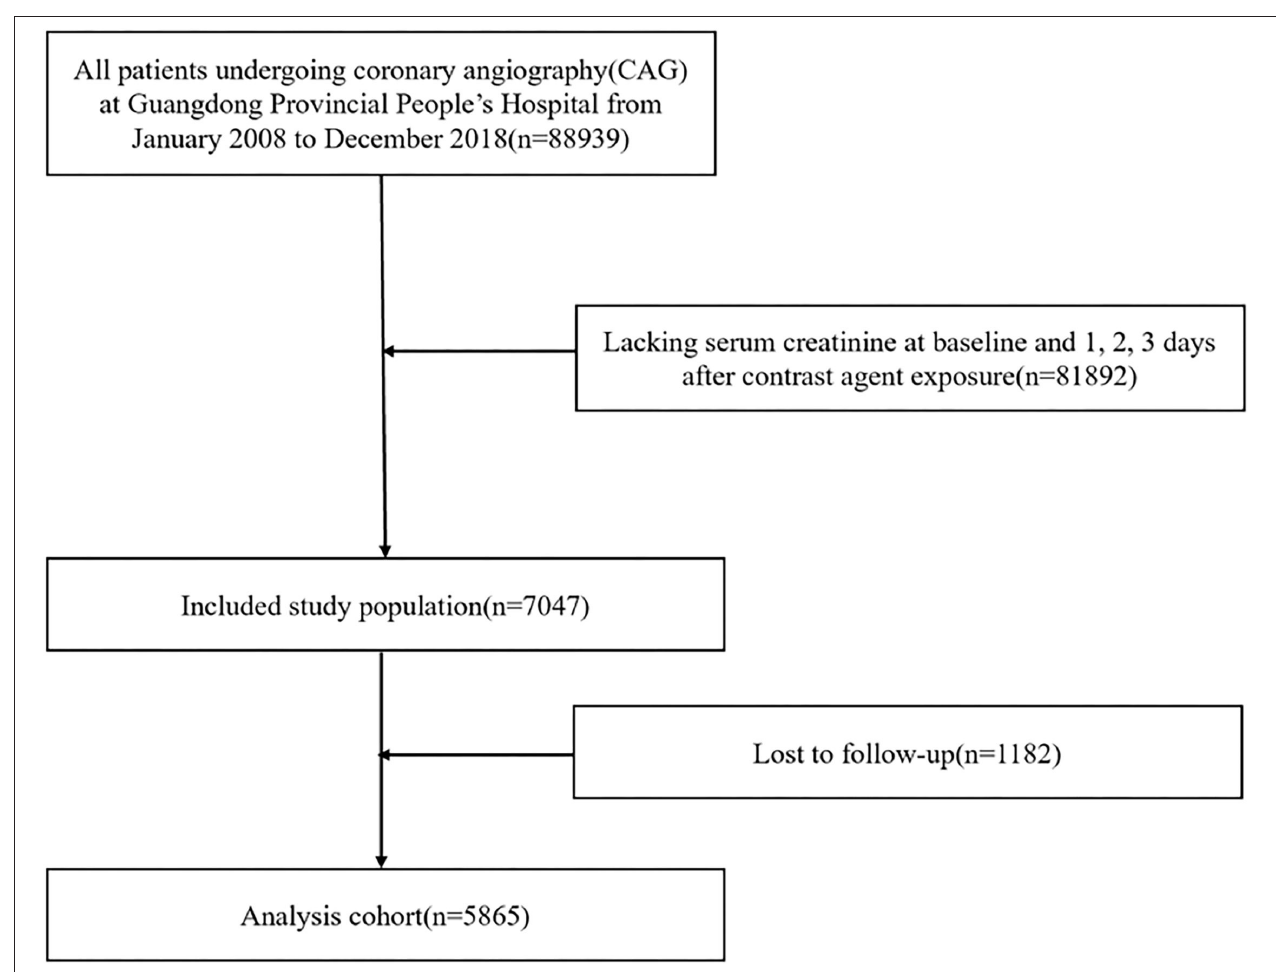
FIGURE 1 | Study flow